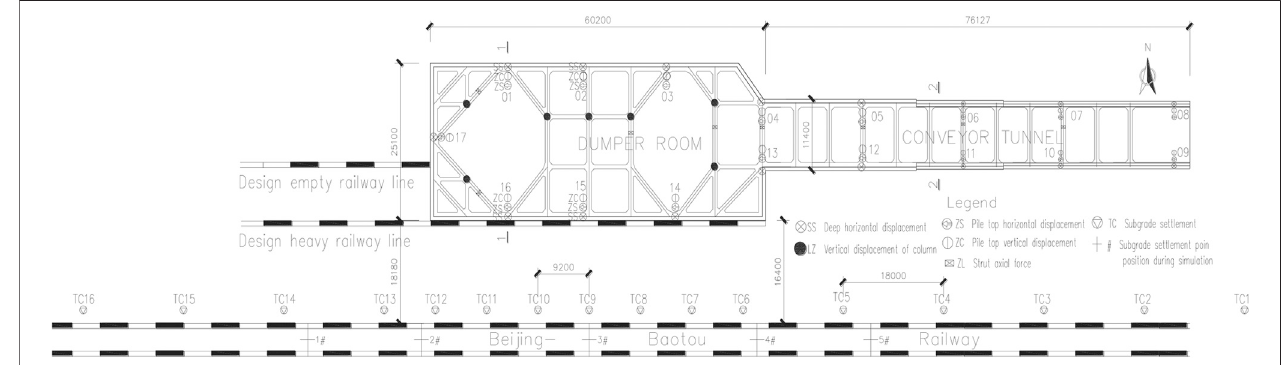
FIGURE 2 | Arrangement of the monitoring points around the car dumper room (size unit: mm).